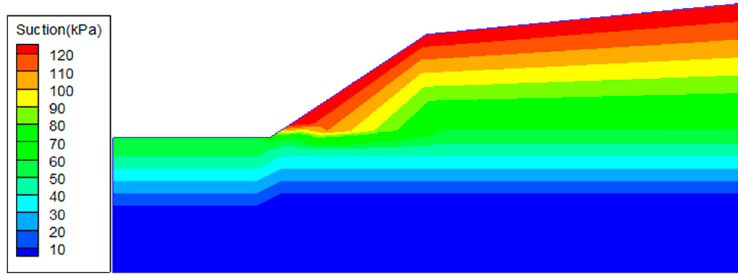
Figure 10. Contours of the water content (unit: %).